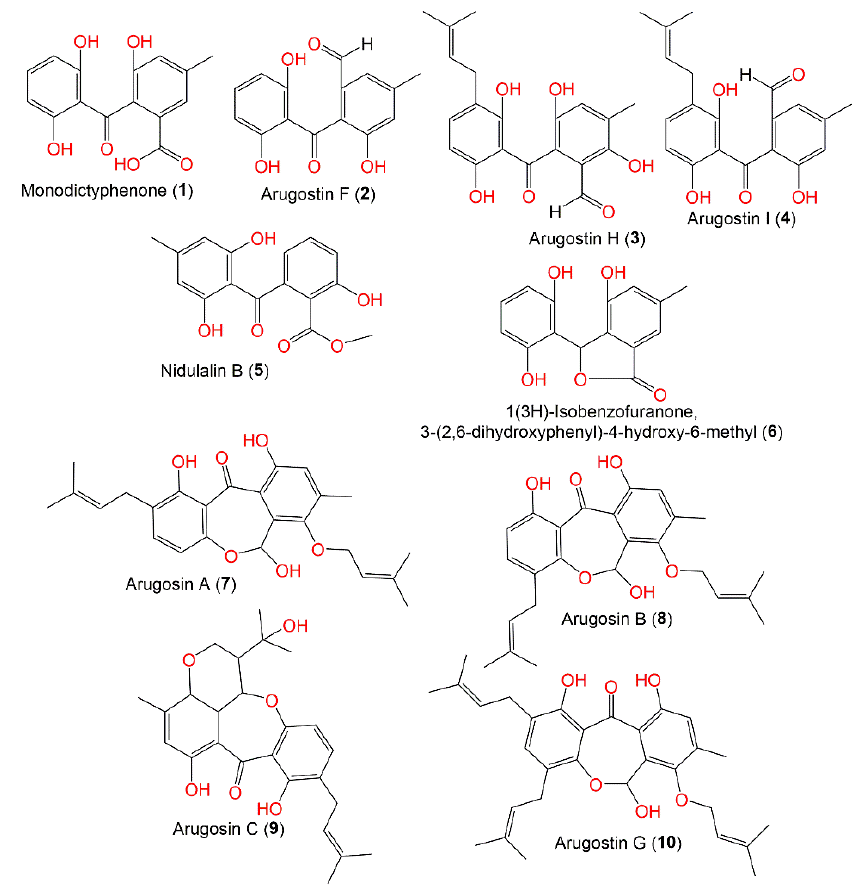
Figure 1. Structures of benzophenones ( 1 – 10 ) reported from Aspergillus nidulans .